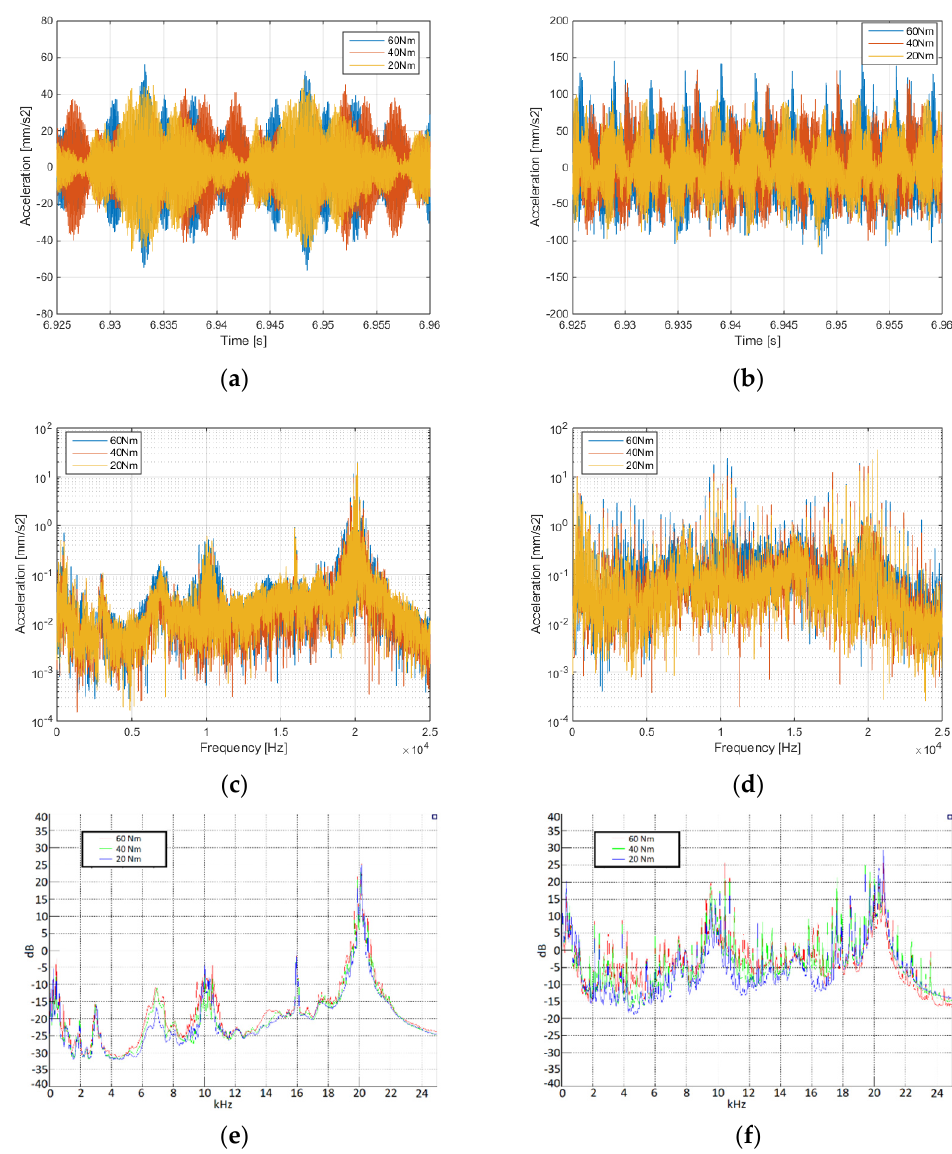
Figure 20. Vibration of the machine at various loads at 45 deg current angle: ( a ) 1000 rpm—time waveform; ( b ) 4500 rpm—time waveform; ( c ) 1000 rpm—FFT; ( d ) 4500 rpm—FFT; ( e ) 1000 rpm— power spectrum; ( f ) 4500 rpm—power spectrum .